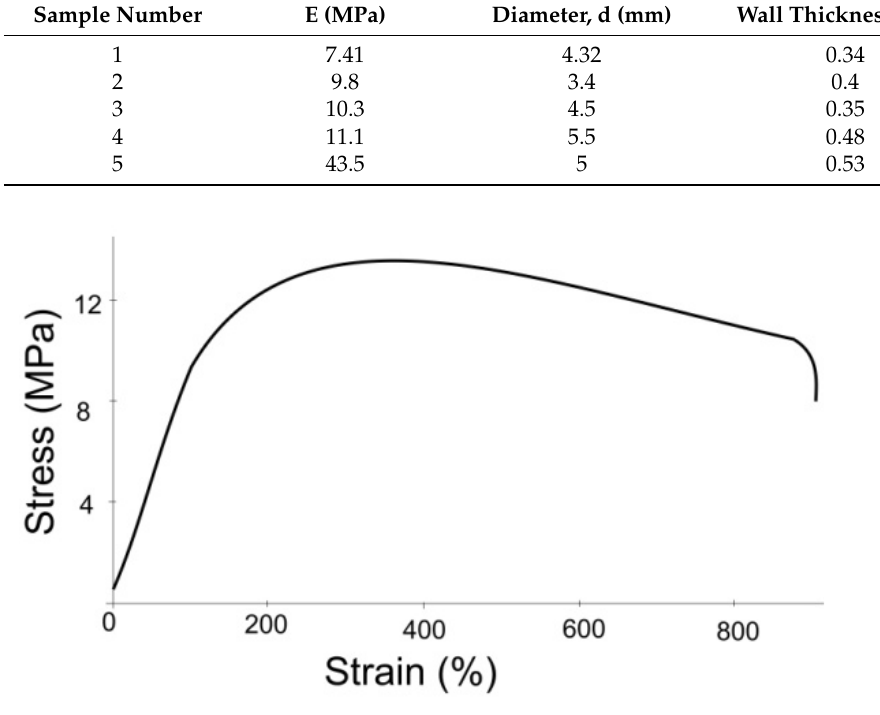
Figure 3. Stress–strain diagram by specimen rupture test.